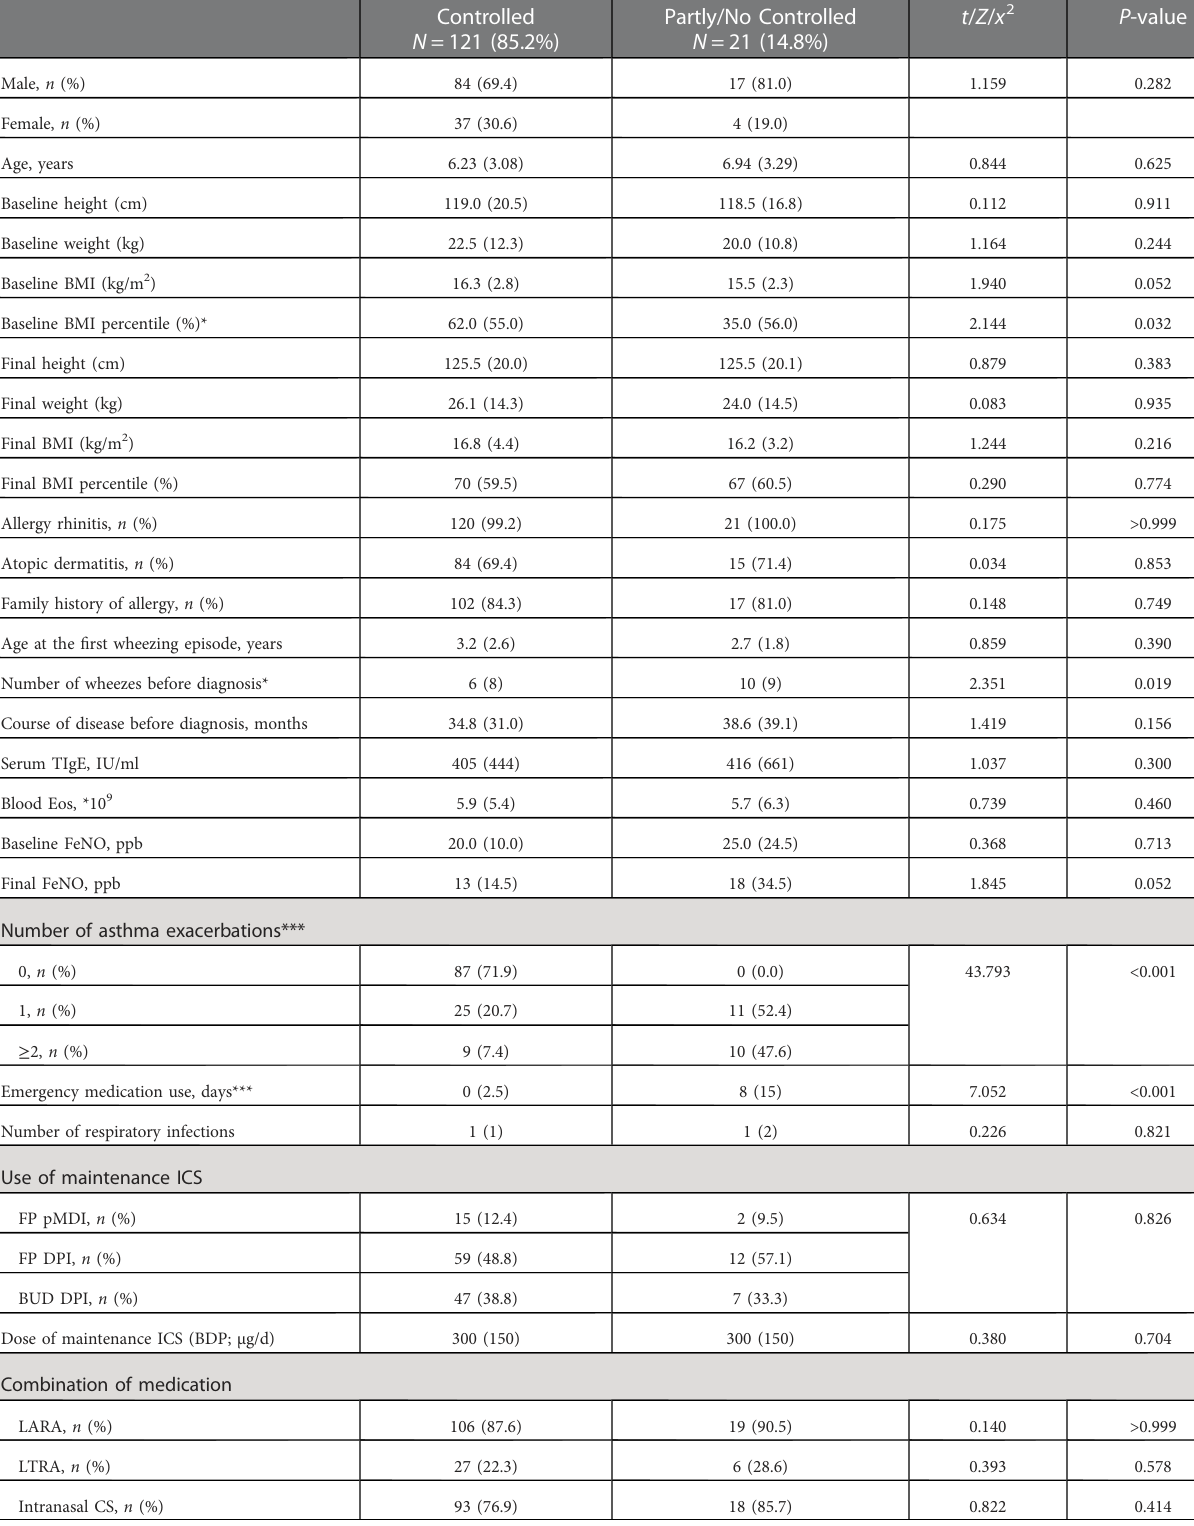
TABLE 4 Risk factors for different control conditions in children with asthma: from clinical and pulmonary physiologic